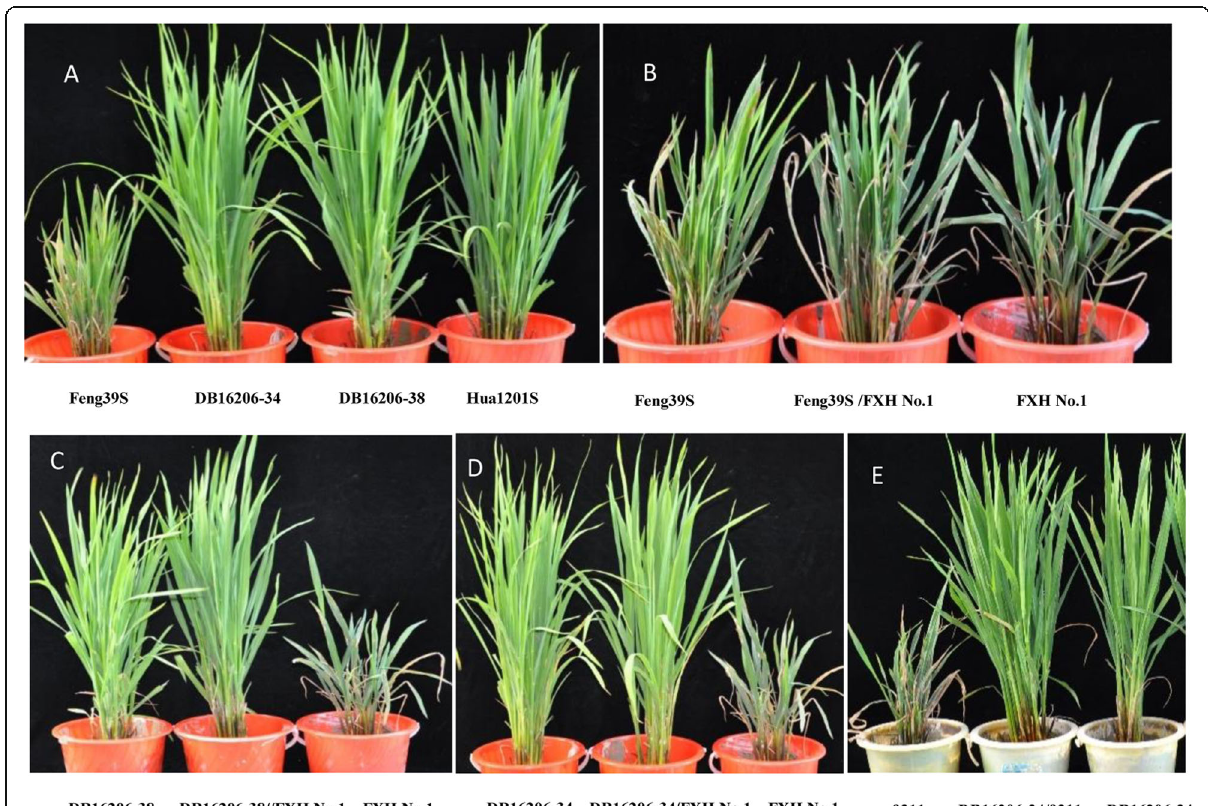
Fig. 3 The performance for leaf blast of the two selected PTGMS lines, parents, and their hybrids in blast epidemic fields in the summer season of 2018 at Wangjia Village, Yichang City, Hubei, China. a the leaf blast reactions of two selected PTGMS lines and their parents. b the leaf blast reactions of two blast susceptible parents and the derived hybrid. c , d and e the leaf blast reactions of partial hybrids derived from the improved PTGMS lines crossing with male parents, FXH No.1 and